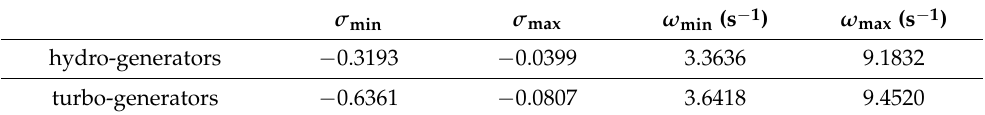
Table 4. The boundaries of real and imaginary parts of local mode eigenvalues of hydro and turbo synchronous generators of different nominal powers in an operating range from P = 0.0 pu to P = 1.0 pu and from Q = 0.0 pu to Q = 1.0